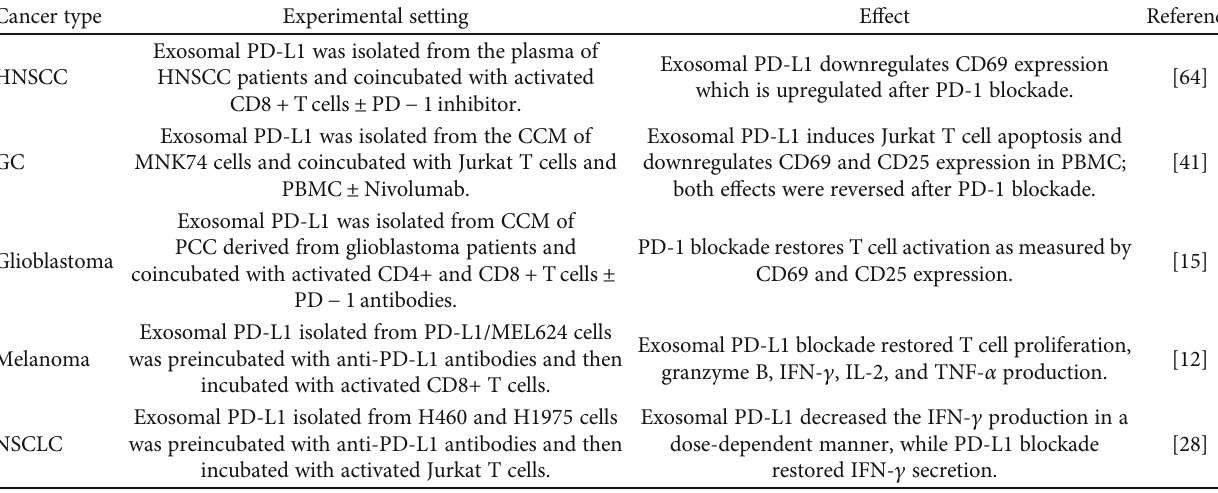
Table 2: Immunological e ff ects of blocking exosomal